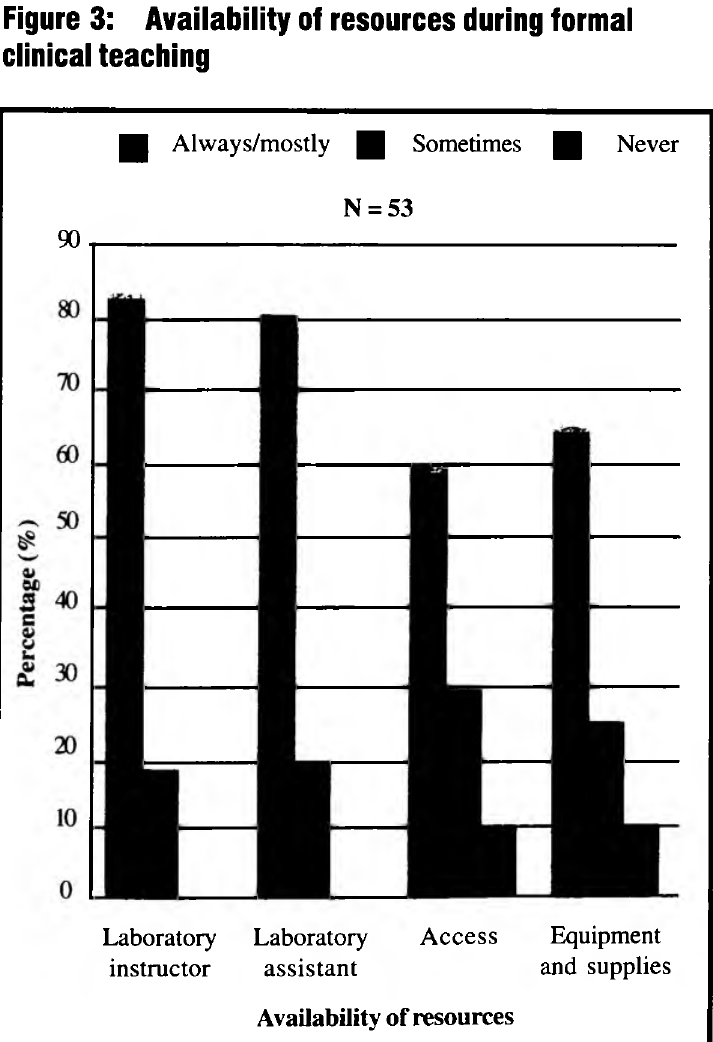
Figure 3: Availability of resources during formal clinical